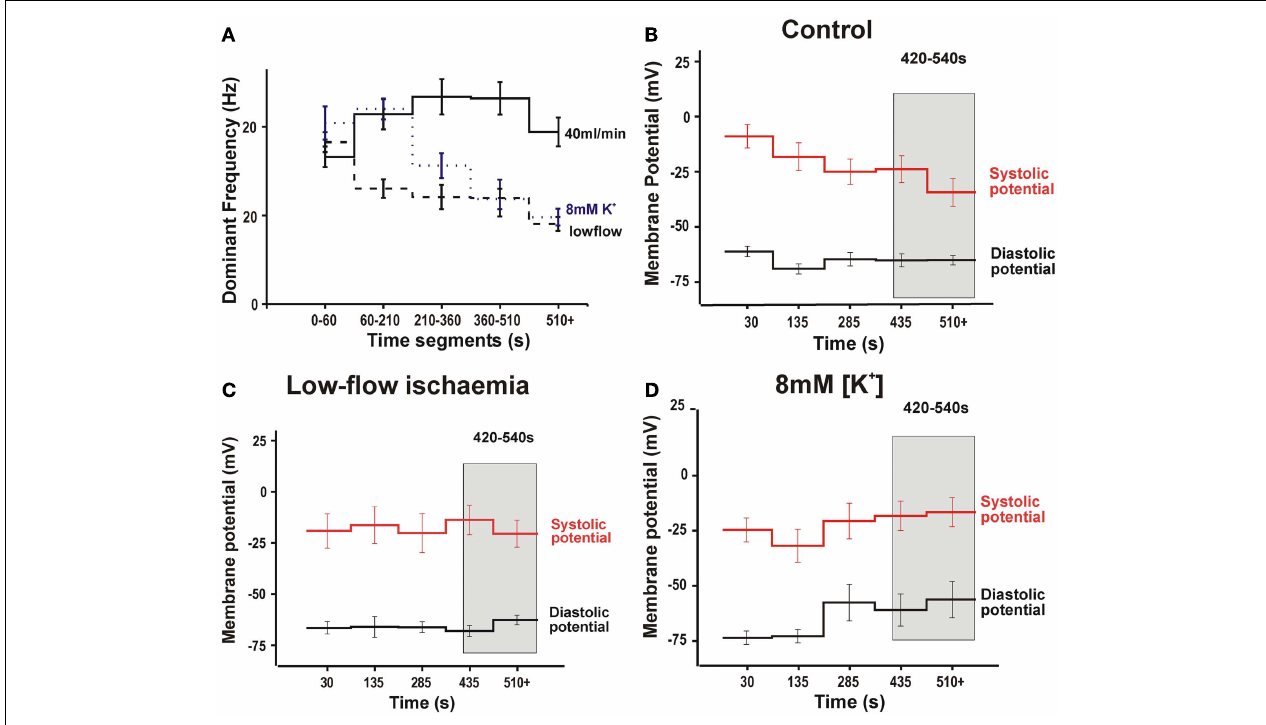
duringVF in low-flow ischemia. (D) Membrane potential duringVF in 8mM [K + ] solution. (Gray bar highlights time interval of 420–540s used for statistical comparison).